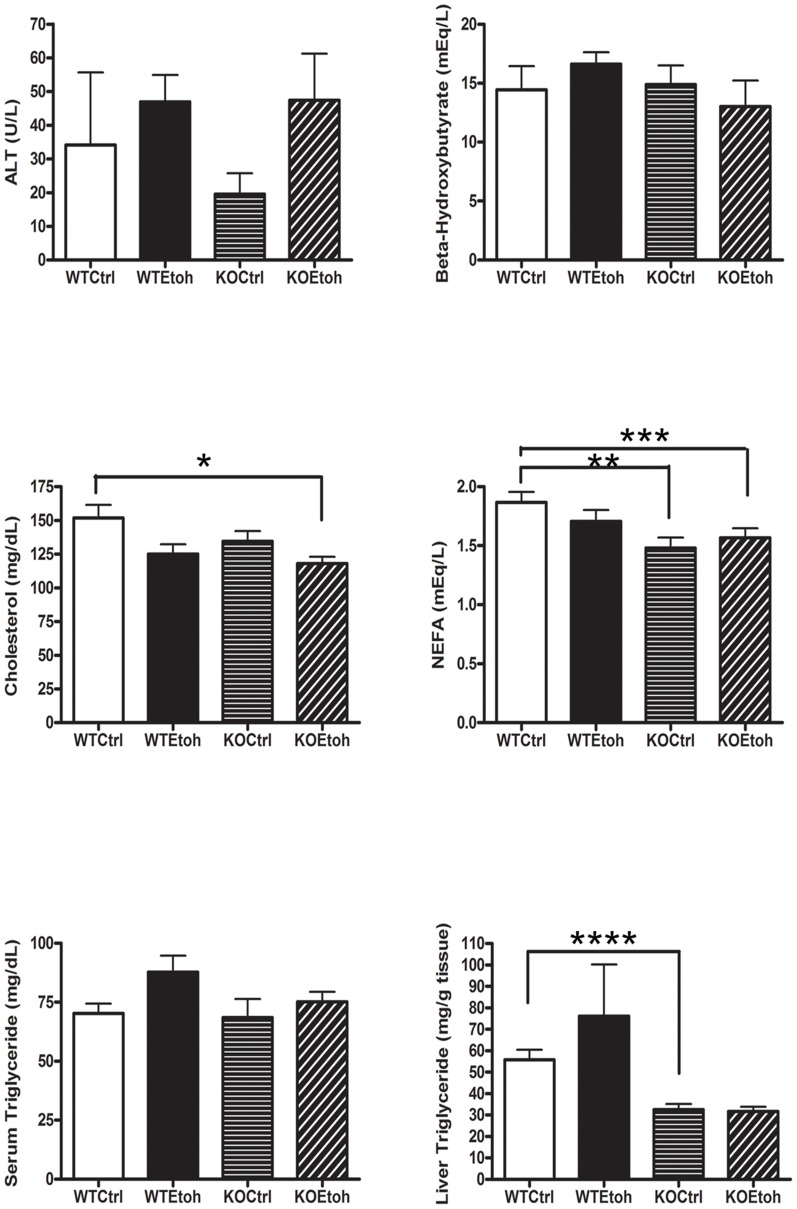
Serum and liver chemistries of wildtype and Plin2KO mice fed control or ethanol diets.Graphs depict results of serum and liver assays on wildtype (WT) and Plin2KO (KO) mice after six weeks of feeding a control (Ctrl) or ethanol (Etoh) diet. N = 5 mice/group. Data reported are mean ±SEM. *p = 0.01 **p = 0.02 ***p = 0.04 ****p = 0.002. p<0.05 is considered significant.